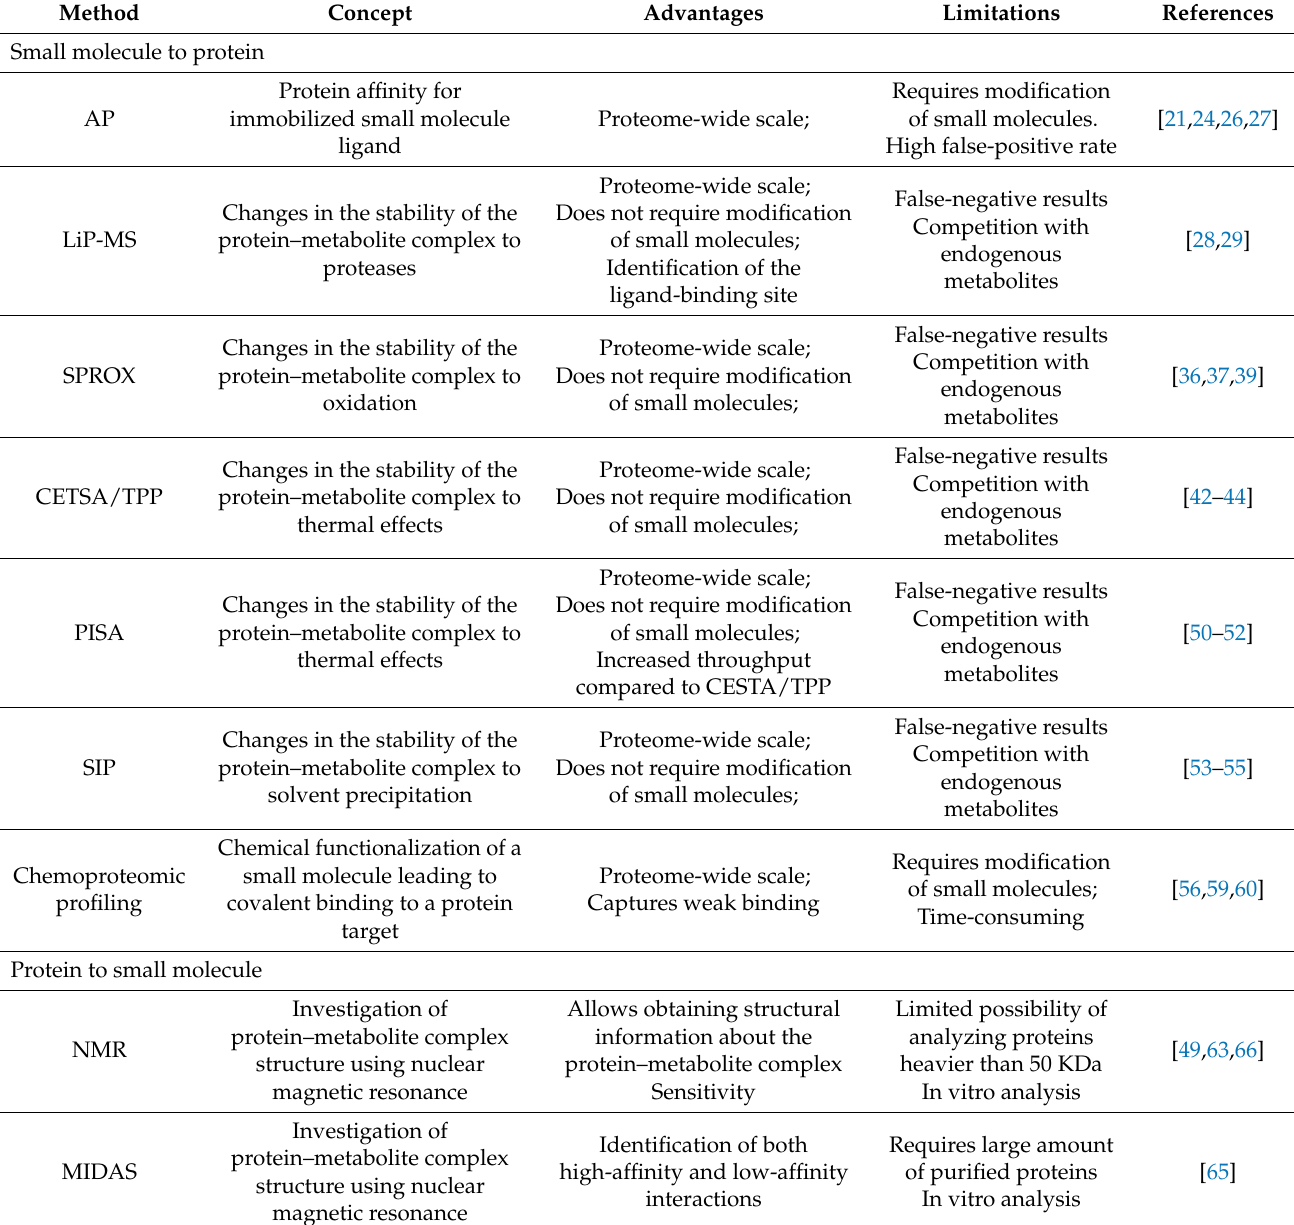
Table 1. Summary of the principles of the methods described in the text, as well as their strengths and